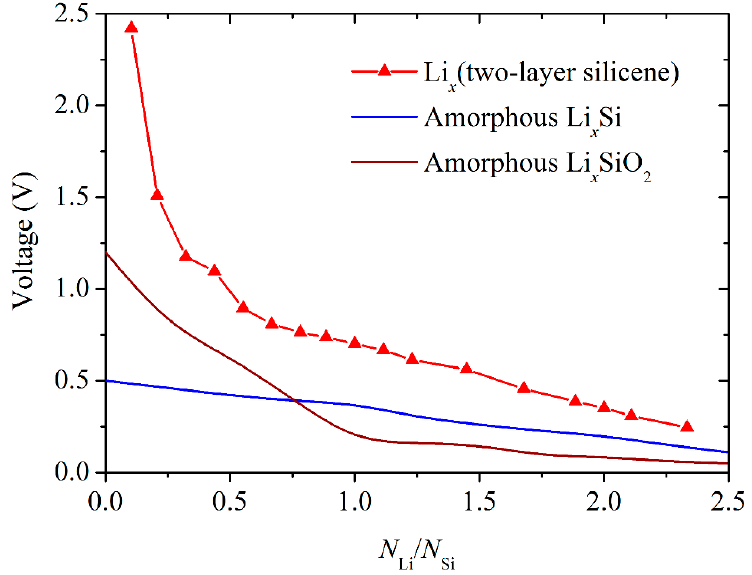
Figure 2. Calculated averaged electrode potential profile for bilayer silicene, amorphous lithium silicide, and lithium silicate.